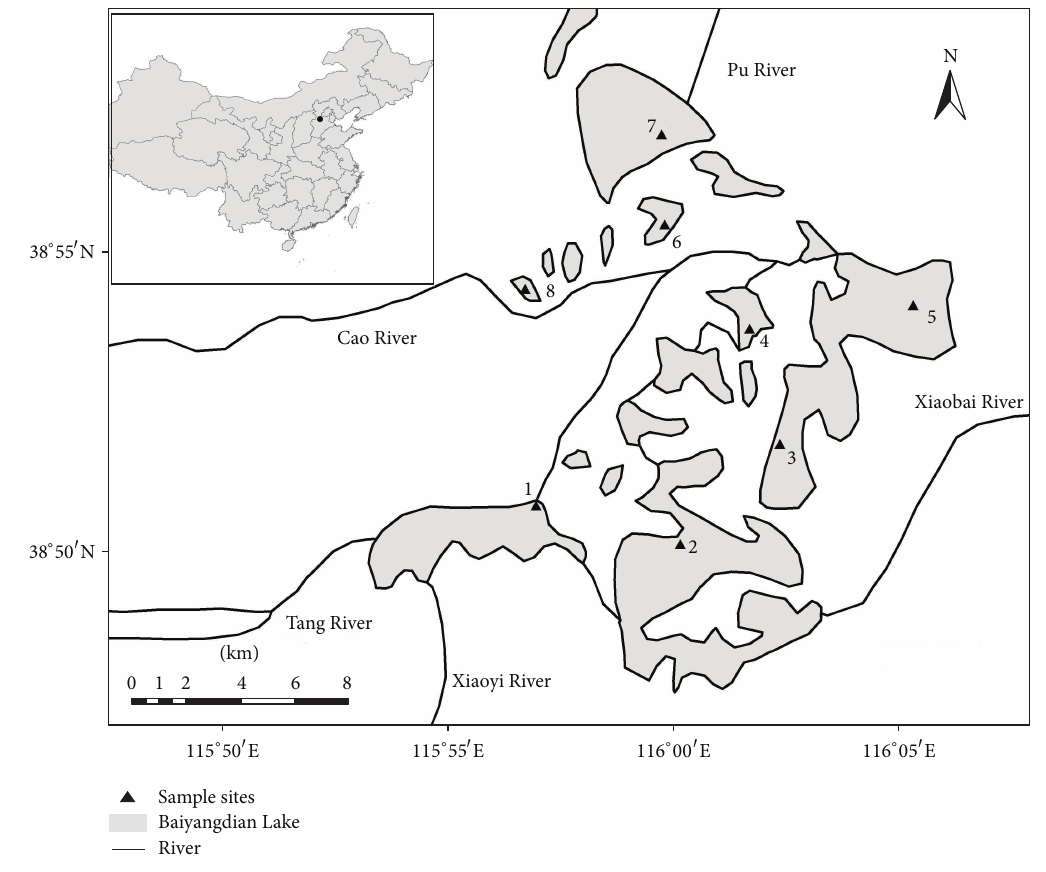
Figure 1: Sampling sites of the Baiyangdian Lake in Hebei Province, China.